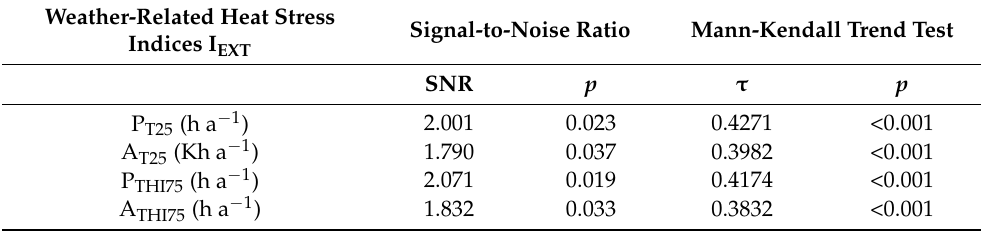
Table 3. Statistical analysis of the temporal trend of the weather-related vector of heat stress (HS) Trend Test with the test statistics τ with the corresponding p